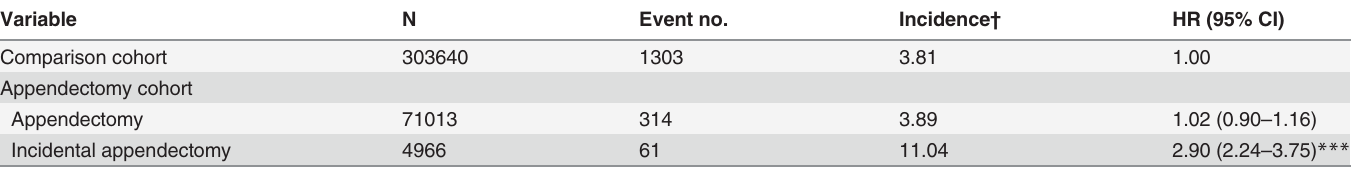
Table 4. Incidence and hazard ratio of colorectal cancer in different types of appendectomy. Variable N